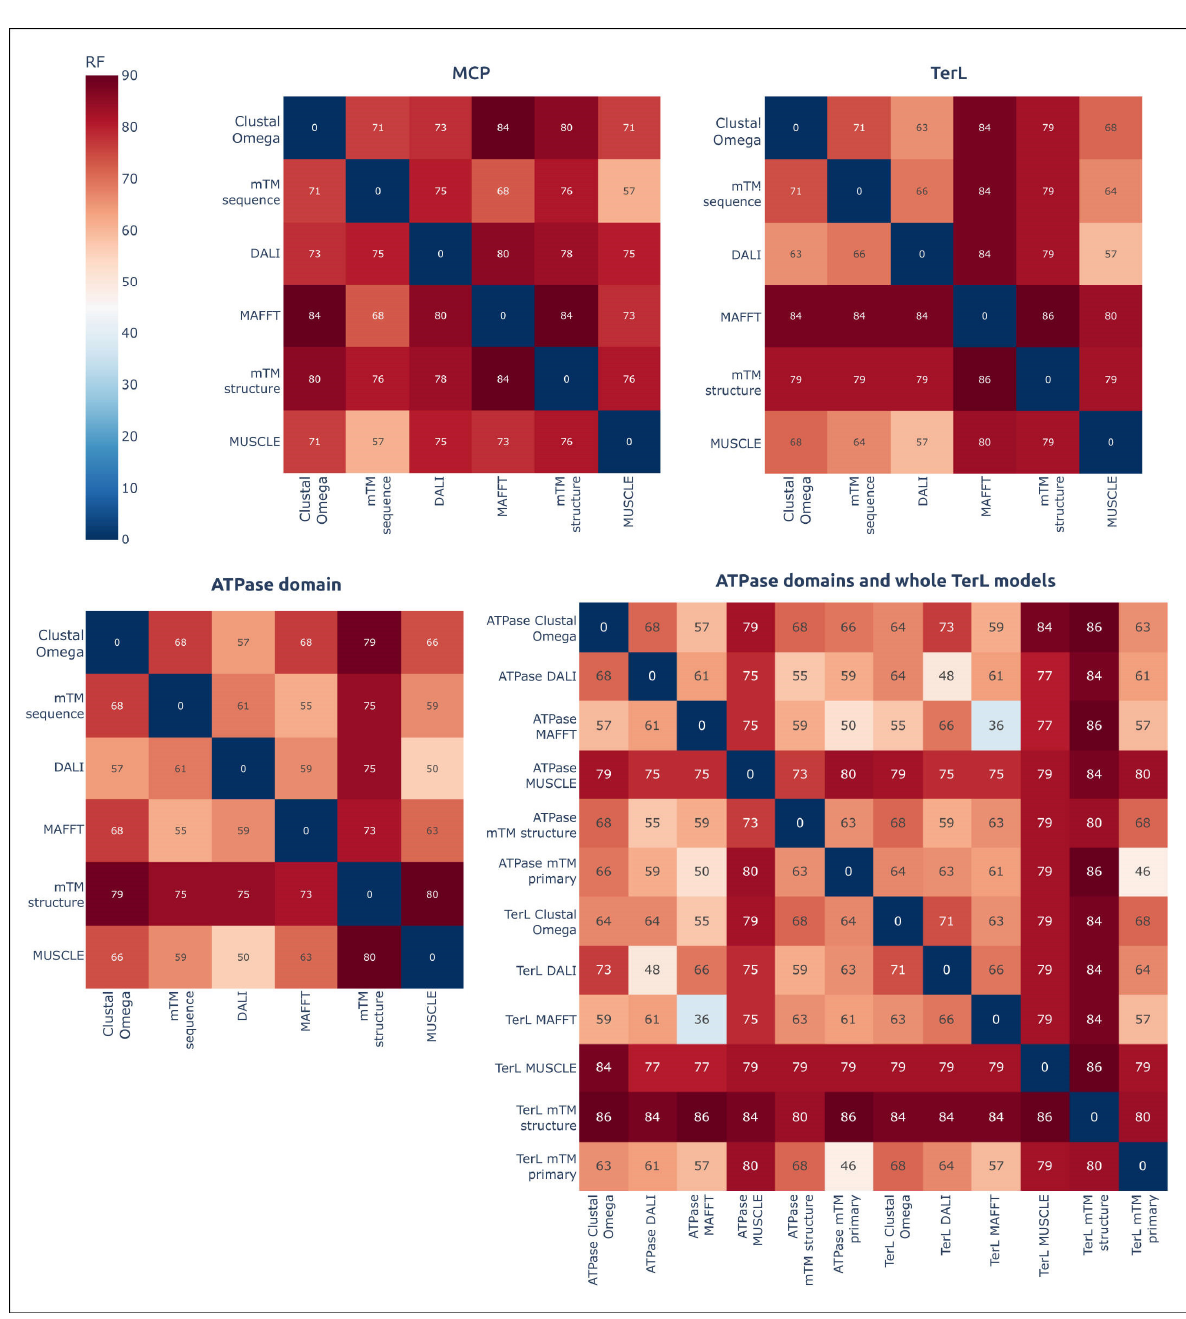
Figure 12. Comparisons of the topological congruence of trees, obtained using structural alignments and different amino acid sequence alignments, and also the normalised RF score shown in